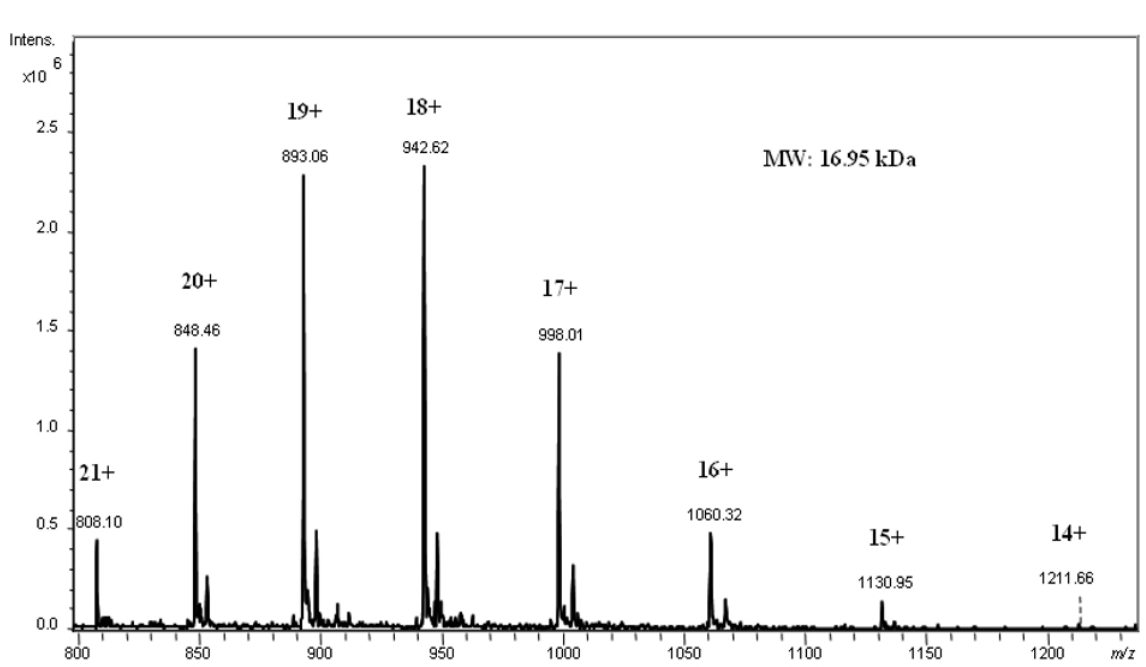
Figure 6. NanoMate-HCT MS 1 of horse apomyoglobin. Concentration 0.5 pmol µL -1 H